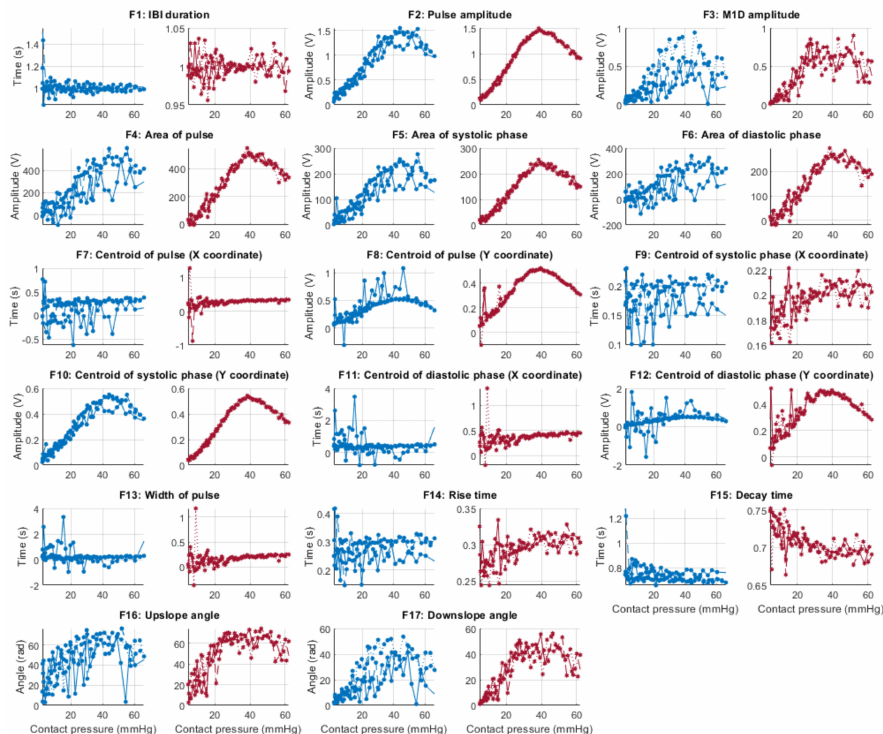
Figure 7. Behaviour of the extracted features during normotension when compared against contact force. Blue lines: Infrared PPG-derived features. Red lines: Red PPG-derived features.